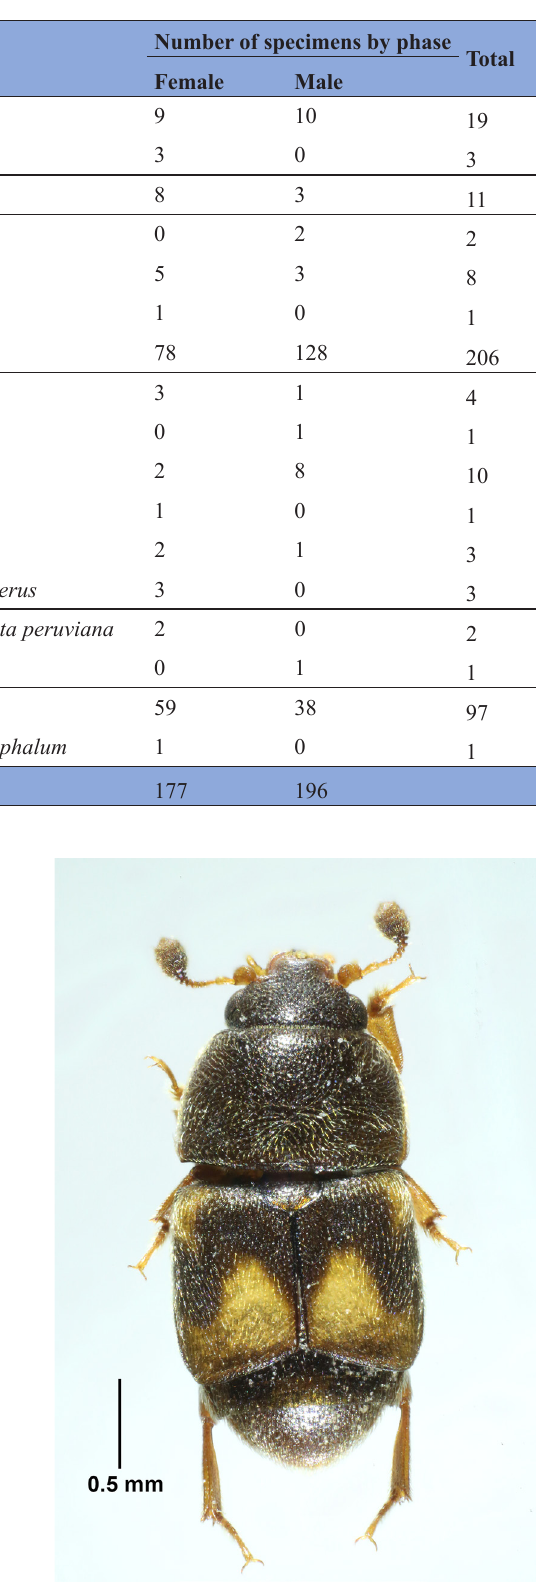
Table 1. Order, family, genus, species, and number of specimens collected in the female and male phase of cherimoya flowers from October 31 to November 15, 2018, La Molina, Lima, Peru